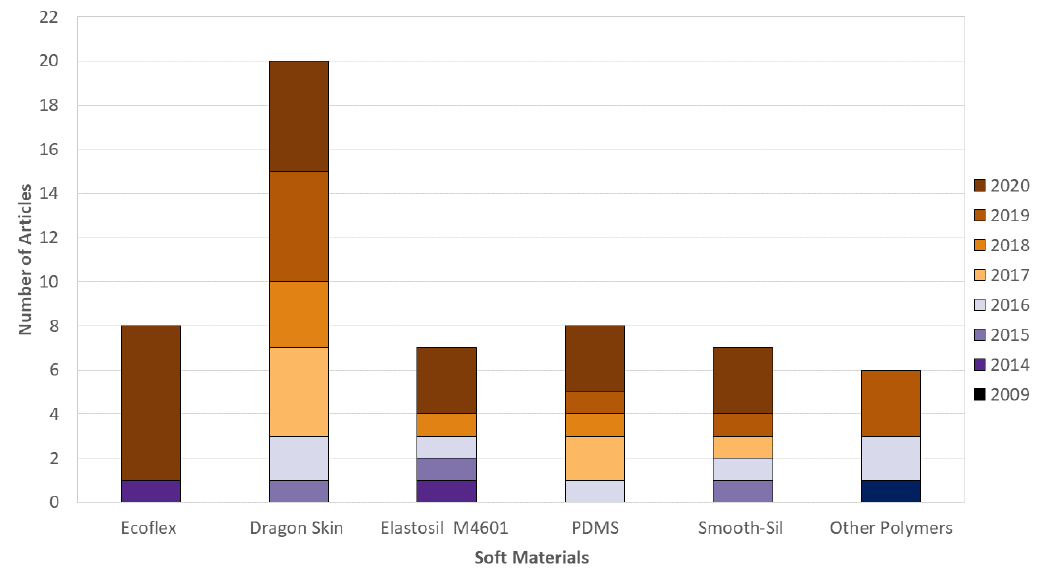
Figure 5. Silicone elastomers and other polymers used in soft robotics literature, as well as the corresponding number of citations. For this graph, 45 articles were examined: Ecoflex [198–205], Dragon Skin 10/20/30/FX-Pro [206–225], Elas- tosil M4601 [199,202,218,226–229], PDMS [198,208,230–232,232–234], Smooth-Sil [200,207,209,218,222,223,227] and Other Polymers